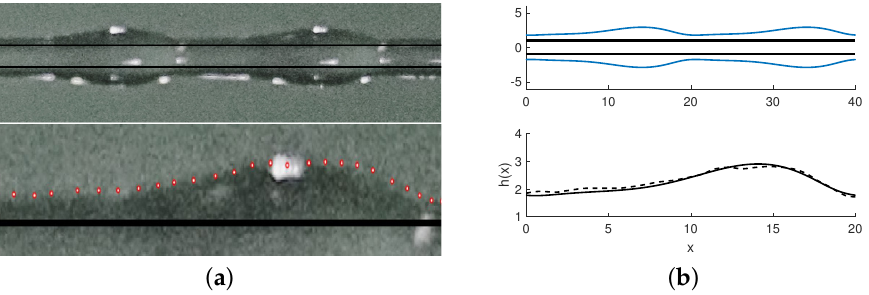
Figure 8. ( a ) Zoomed photo of the droplets with edge detection indicated below by the series of red dots. ( b ) Match between the edge of the drop and a numerical simulation corresponding to the parameters found by Machine Learning: h 0 = 2.29, b = 12.32 and a =